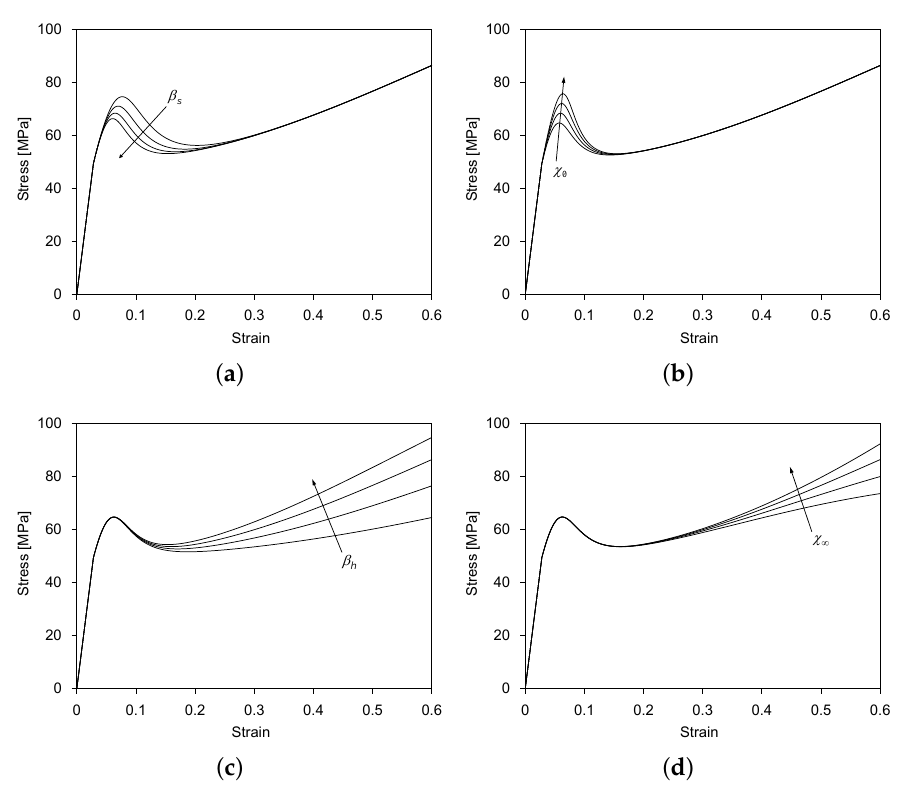
Figure 1. Effects of the model parameters ( a ) β s , ( b ) χ 0 , ( c ) β h , ( d ) χ ∞ on the softening and hardening behavior; arrows indicate the value increase of the respective